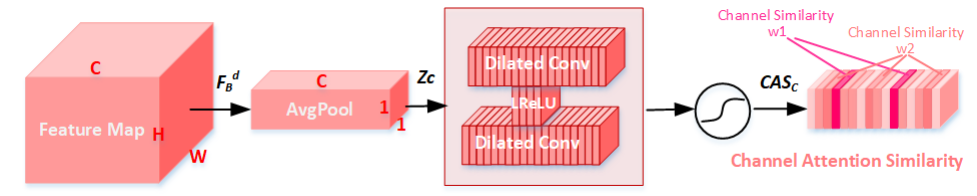
Figure 3. Channel attention similarity module. Channels with similar pixels have similar weights, and key channel features have larger weights. The two dark red channels in the figure are similar and have a similar weight w 1.